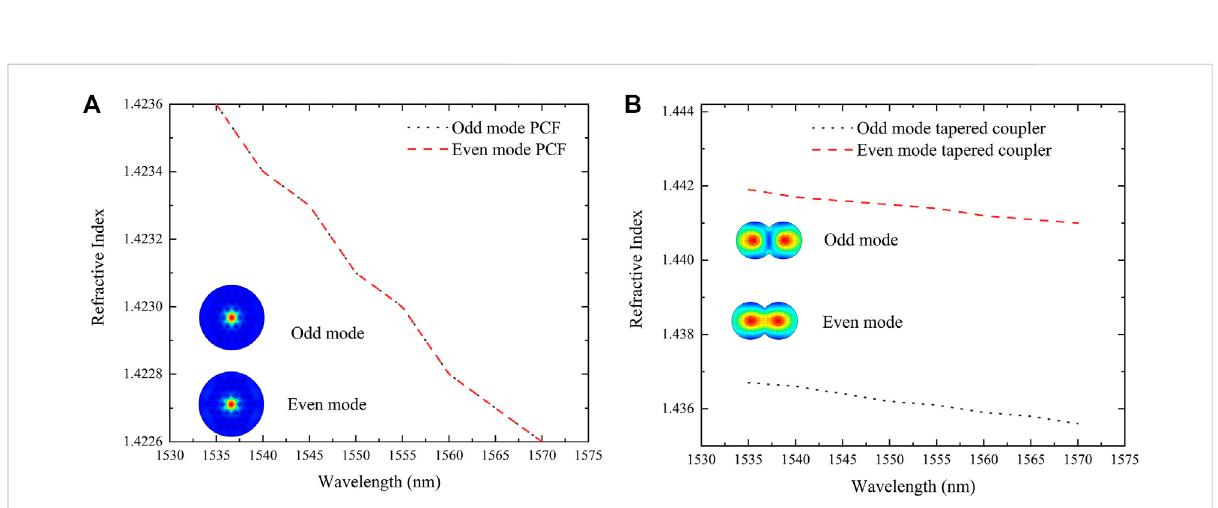
FIGURE 3 Optical fi ber mode refractiveindexsimulation and electric fi elddiagram. (A) Partial refractiveindexsimulation andelectric fi eld diagram ofPCF. (B) Partial refractive index simulation and electric fi eld diagram of tapered